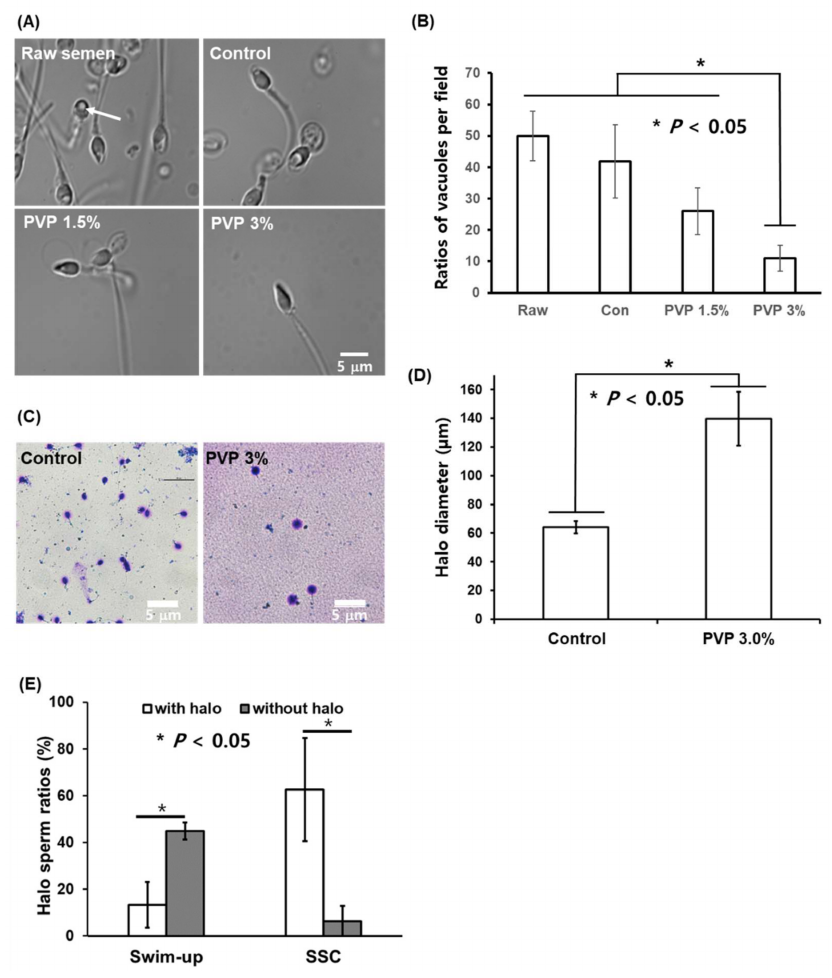
Figure 5. Sperm-head vacuoles of raw semen as well as control, 1.5%, and 3% PVP media observed under an optical microscope, and sperm DNA integrity. ( A ) Microscopic images of sperm in the control, 1.5%, and 3% PVP media under high magnification, where the arrow indicates a nuclear vacuole in the sperm head; scale bar: 5 µ m. ( B ) Number of sperm with vacuole heads in the raw semen, control, 1.5% PVP, and 3% PVP based on microscope image analysis. ( C ) Evaluation of sperm DNA fragmentation using halosperm kit with a bright-field microscope and quantitative analysis of halo sizes between raw semen and 3% PVP. Human sperm stained using the halosperm kit were assessed by size measurements; sperm without DNA fragmentation showed large halos, whereas those with fragmented DNA showed smaller halos. scale bar: 5 µ m ( D ) Halo sizes of sperm selected by the SSC with PVP 3% were greater than those with the control medium, indicating low DNA fragmentation. The significant differences are indicated by asterisks (* p < 0.05 against control). ( E ) Halo sperm ratios analysis for swim-up sperm and SSC sperm. The significant differences are indicated by asterisks (* p < 0.05 against